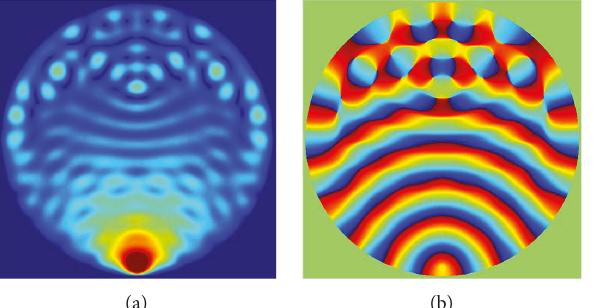
Figure 7: Amplitude (a) and phase (b) of the fi eld (35) in the empty water- fi lled casing. An upper limit of 0.2 was chosen in the image of the amplitude.